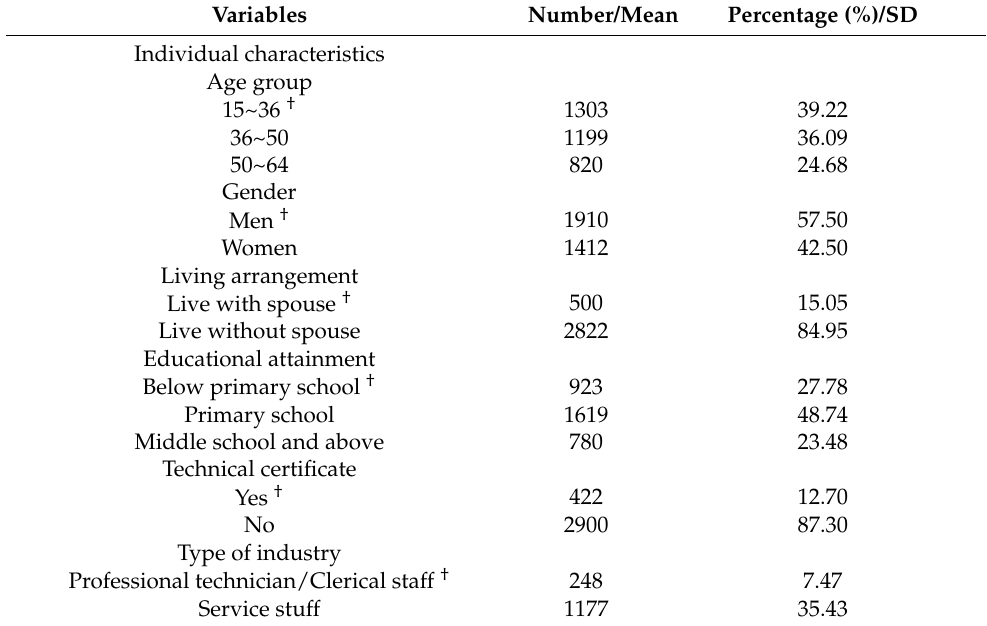
Table 1. Statistics for the characteristics of